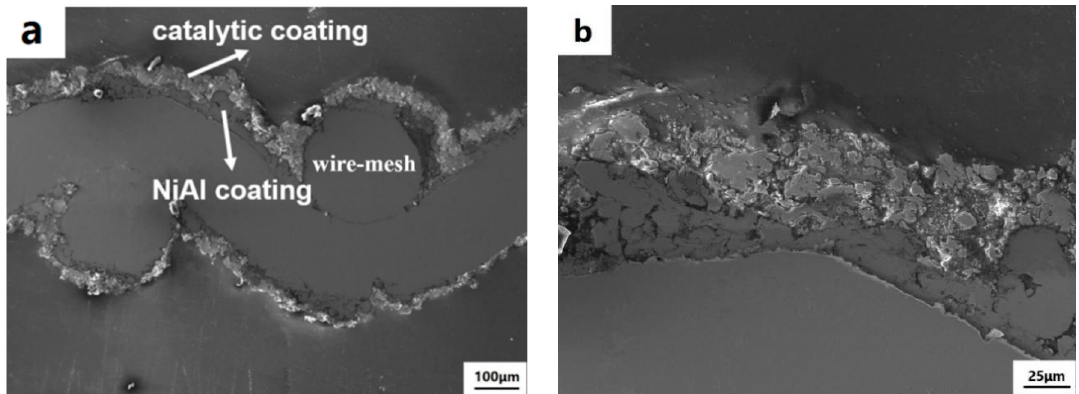
Figure 11. ( a ) Sectional morphology of the wire-mesh, ( b ) Enlarged SEM sectional morphology of the Figure 11. ( a ): Sectional morphology of the wire-mesh, ( b ): Enlarged SEM sectional morphology of the wire-mesh.